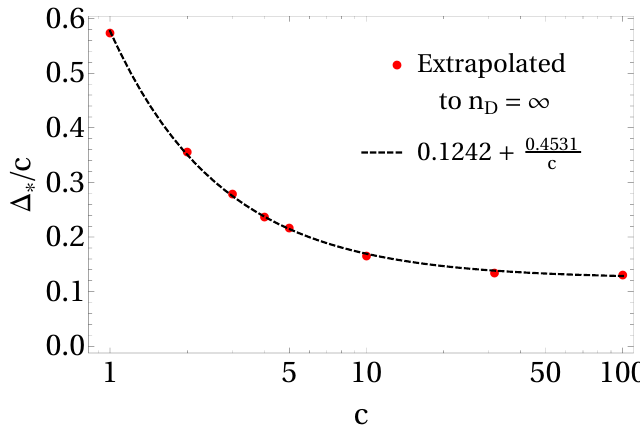
Figure 1 . Bounds of the dimension of lightest charged state assuming the theory has U(1) sym- metry. The extrapolated gaps at n D ! 1 with the trend